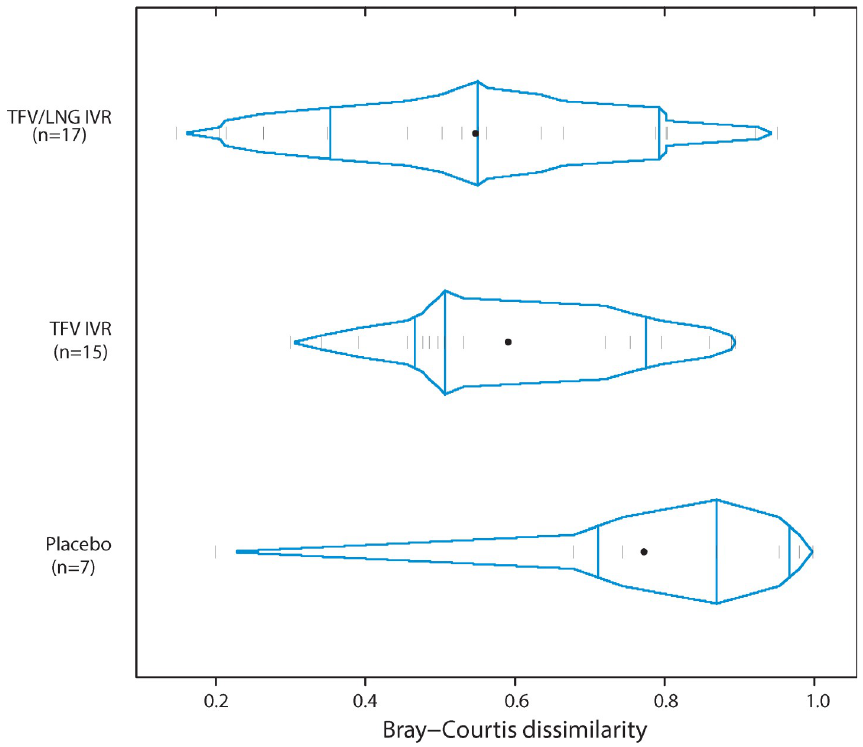
Fig 3. Bray-Curtis dissimilarities calculated using phylotype absolute abundances at visit 7 and visit 4 for TFV/ LNG IVR, TFV IVR and placebo user groups. https://doi.org/10.1371/journal.pone.0217229.g003 Table 1. Frequency table of the number of participants, per IVR, with each community state type (CST) at insertion of IVR at visit 4 (row) versus removal of IVR at visit 7 (column). Paired Placebo IVR data (n =